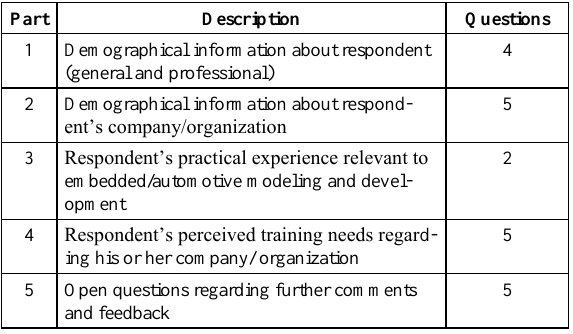
TABLE I. S TRUCTURE OF NEEDS ANALYSIS QUESTIONNAIRE